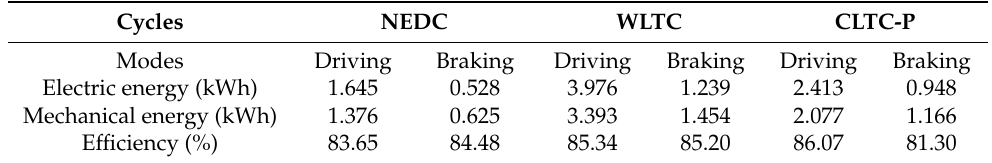
Figure 7. Curves of the mechanical and electrical energy changed with time in the WLTC cycle: ( a ) driving; ( b ) regenerative braking. Table 2. Energy and efficiency in each cycle.